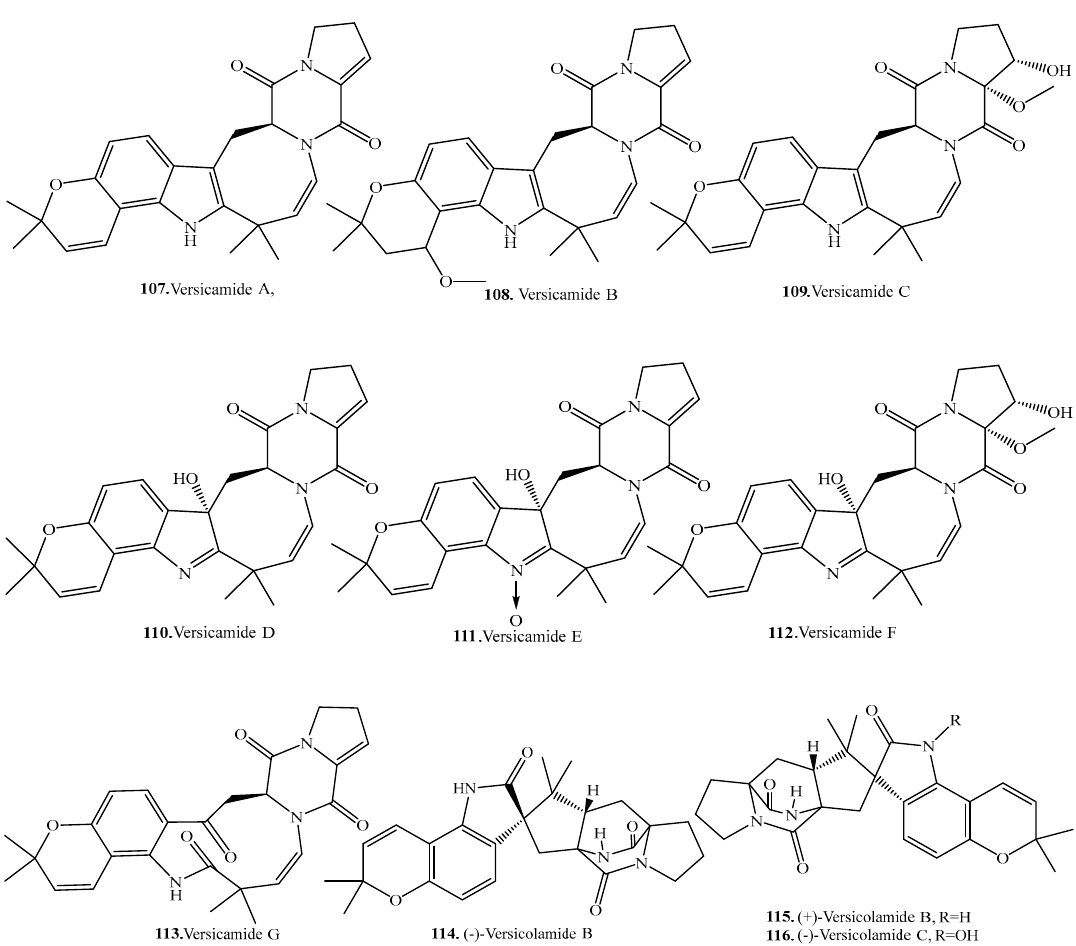
Figure 1. Structures of the tryptophan-proline cyclodipeptide analogs isolated from fungi.